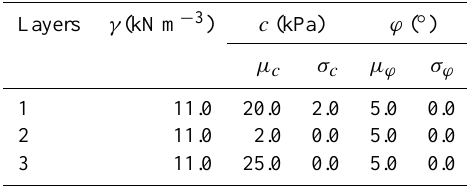
Figure 15. A problem with three soils and vertical pressure for non- circular slip surface analysis. Table 10. Summary of reliability indices for the problem in Fig. 14. Shape of slip surface